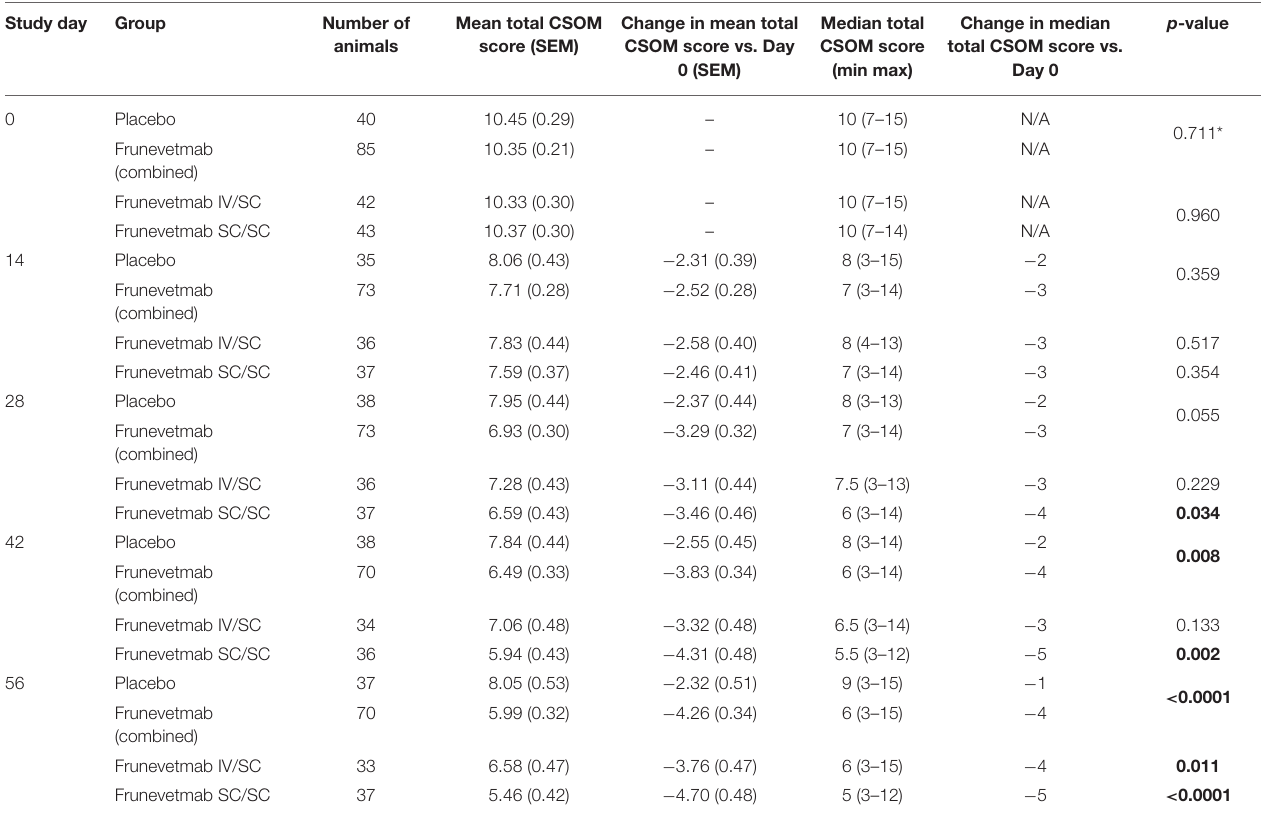
TABLE 3 | CSOM scores, mean (SEM), and median (range) at each time point for each group, and the median changes in CSOM scores for each group at each time point compared to Day 0. Study